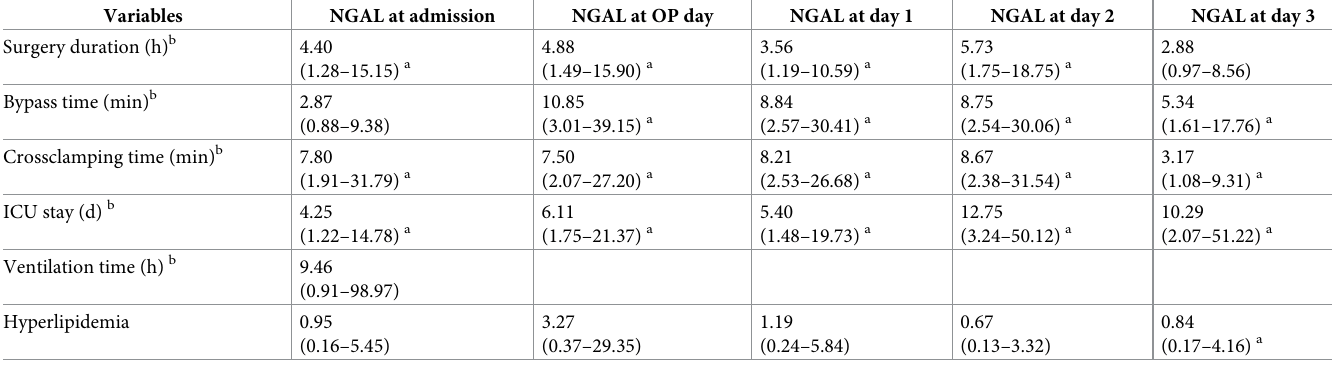
Table 5. Predictors for postoperative occurrence of AKI. Odds ratios refer to NGAL values greater than threshold for AKI development.